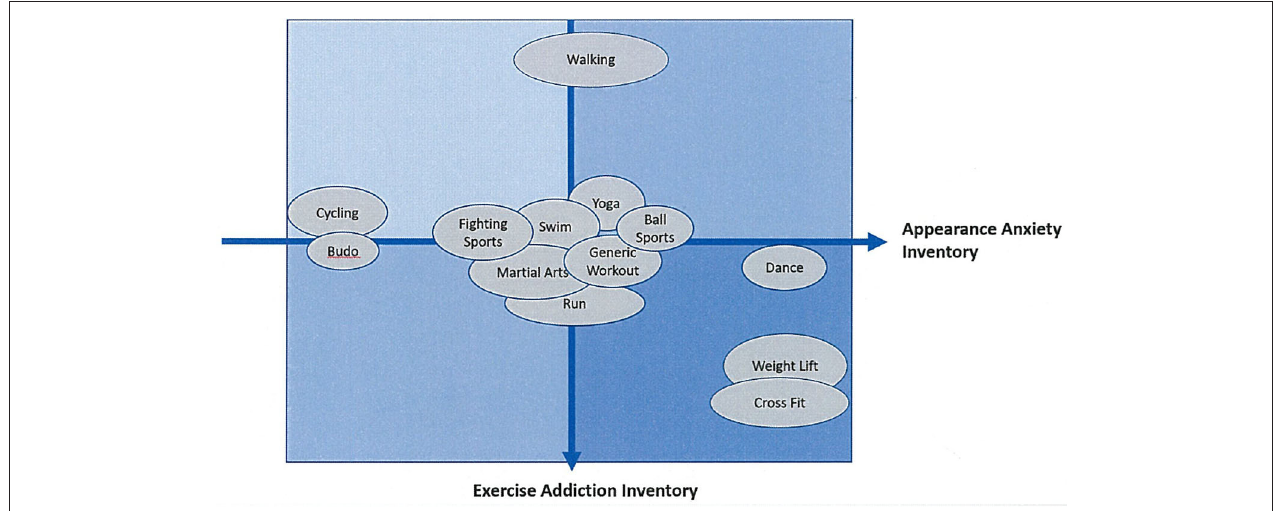
FIGURE 1 | Schematic representation of the features of EAI and AAI on each exercise.